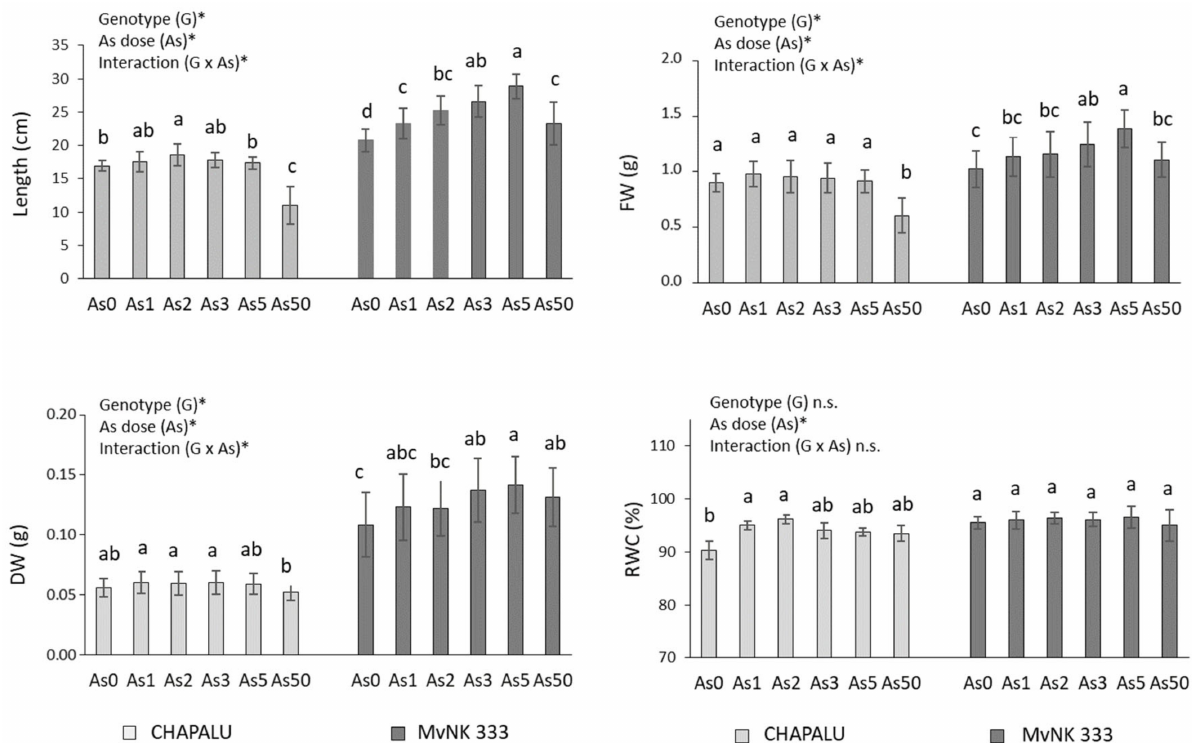
Figure 1. Effect of arsenic (As) on length, fresh weight (FW), dry weight (DW) and relative water content (RWC) of shoots of two maize cultivars and their statistical evaluation. Data are presented as means ± SD from three biological replicates (n = 45 for FW and DW, n = 6 for RWC). As0, As1, As2, As3, As5 and As50—arsenic addition to soil in mg kg − 1 . The differences between variants of the experiment were determined using the Kruskal–Wallis test followed by the Dunn’s post hoc test for multiple comparisons. Different letters on the top of bars indicate a significant difference ( p < 0.05) between variants of the experiment for each cultivar. Data were also examined using two- way ANOVA with the factors As dose (As), genotype (G), and interaction (G x As). *—significance at 0.05 level; n.s.—not